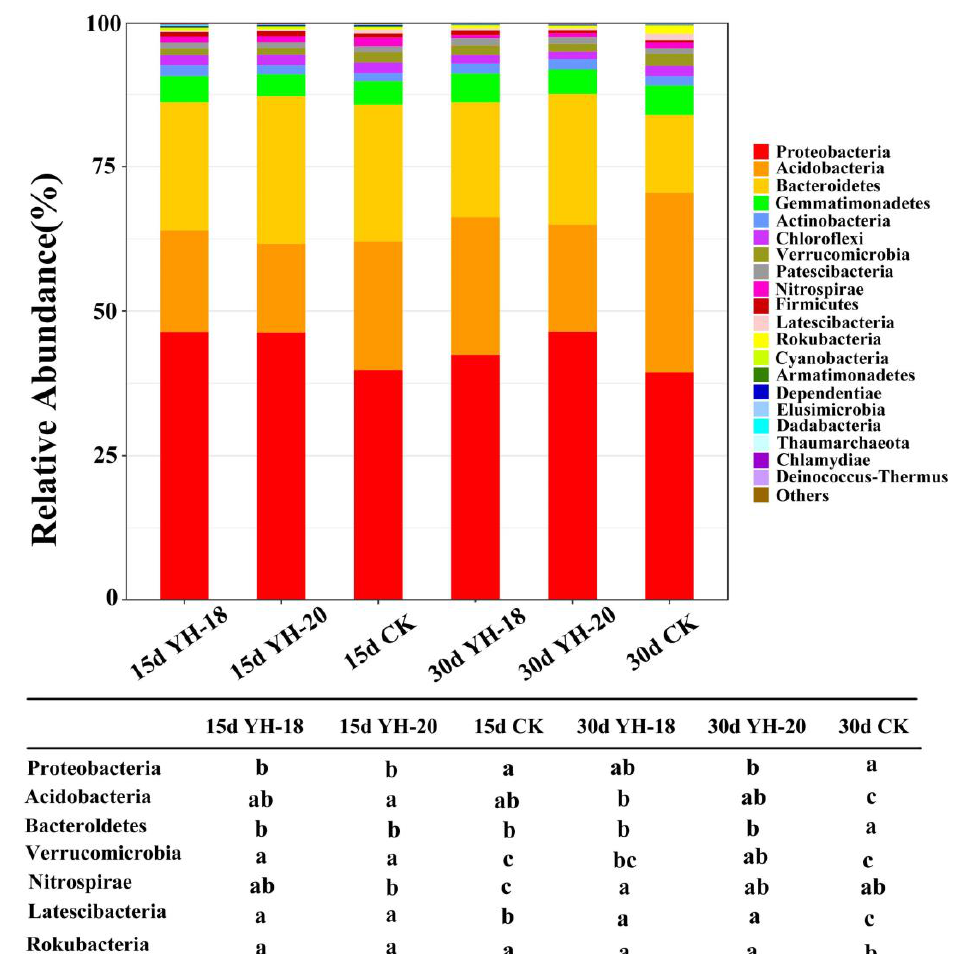
Figure 3. The 20 most abundant bacterial groups at the phylum level. To elucidate the peach seedling-soil feedback processes, the differences in the rhizo- sphere soil microbial populations were compared at the genus level following inoculation. YH-18 and YH-20 significantly enriched Sphingomonas , Pseudomonas , and Devosia and re- duced Bryobacter , Chryseolinea , and Nitrospira in the rhizosphere soil on the 15th day. On the 30th day, Pseudomonas , Flavobacterium , Arenimonas , Aquicella , Devosia , Novosphingo- bium , and Ferruginibacter were significantly enriched, while RB41, Haliangium , and MND1